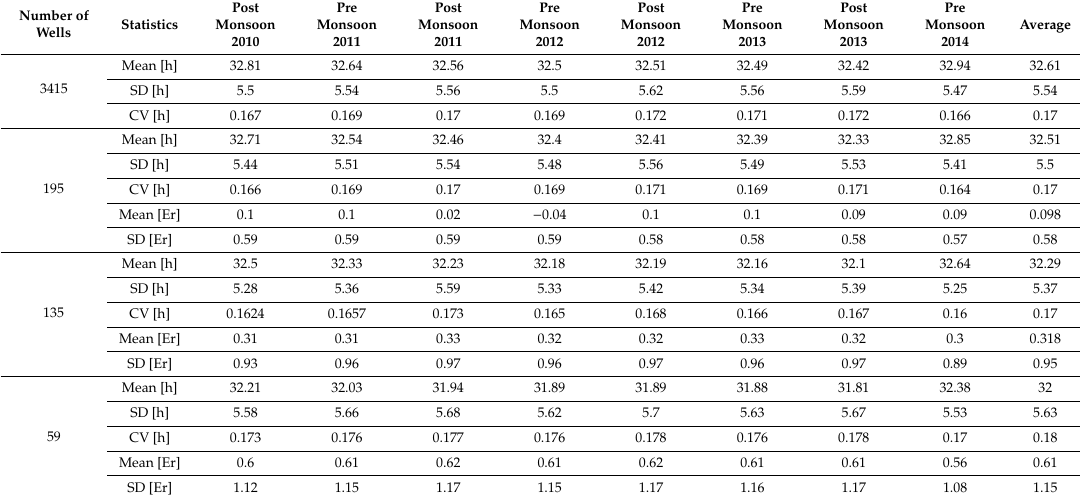
Table 1. Statistics on the reduction of wells in each